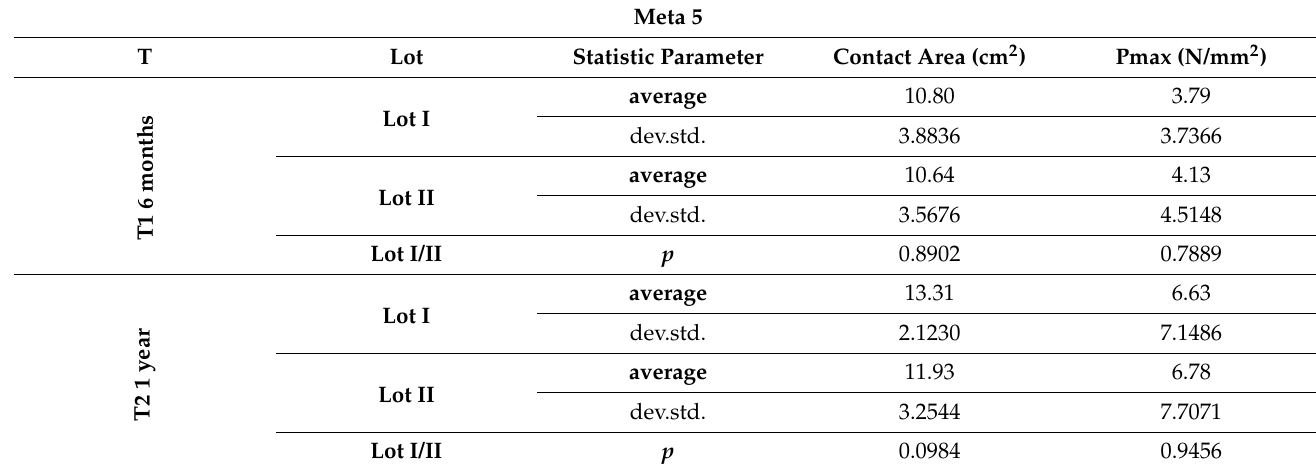
Table 7. Average values Meta 5, 6 months and 1 year. Meta